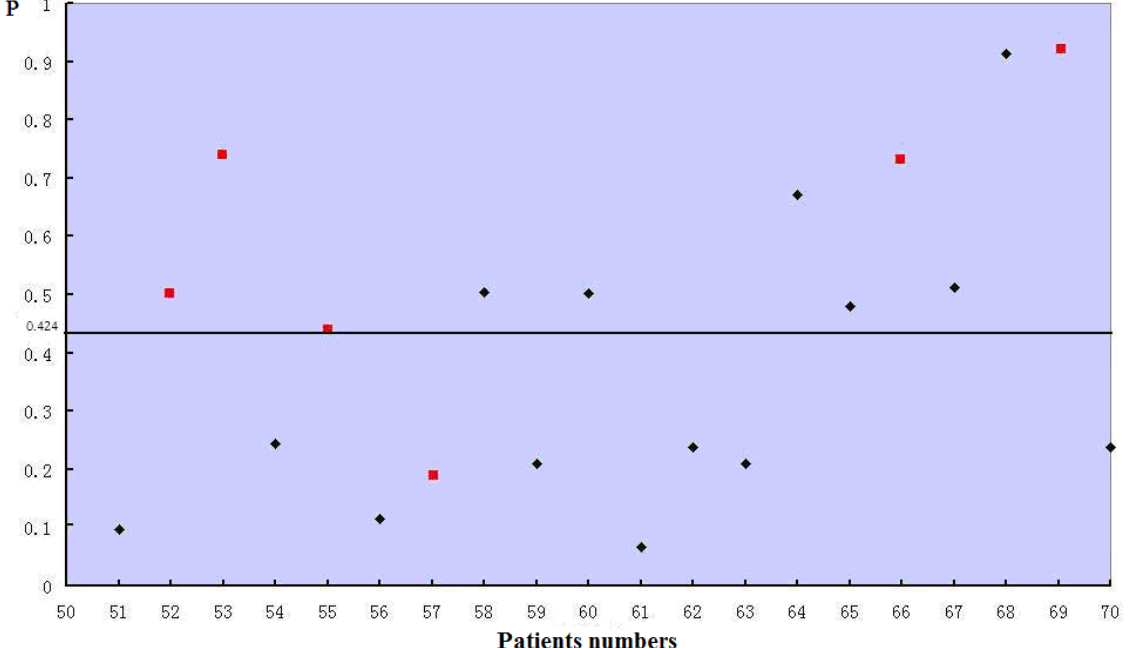
Figure 3. Logistic regression model Scatter diagram (n =